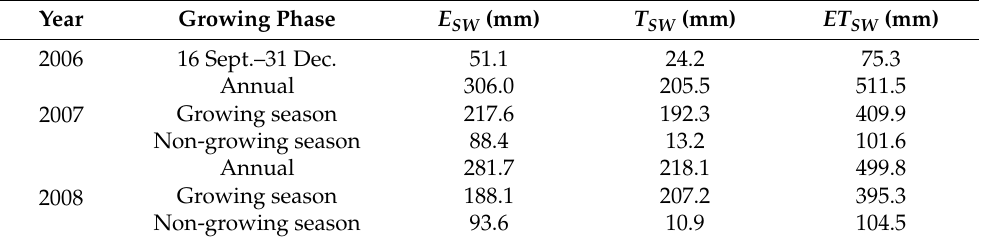
Table 2. Evapotranspiration partitioning during the study period.